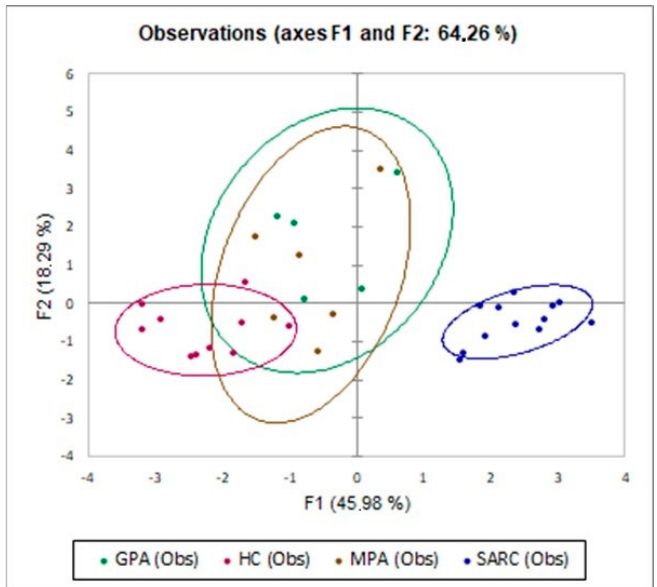
Figure 2. The PCA plot distinguished the disease clusters: MPA, GPA, sarcoidosis and HC showed that they separated on the basis of CD4 + CTLA4 + , CD4 + PD1 + , CD4 + TIGIT + , CD56, CD56 + CTLA4 + , CD56 + TIGIT + , CD8, CD8 + CTLA4 + and CD8 + PD1 + . The first and second components explained 45.98% and 18.29% of the total variance (64.26%).